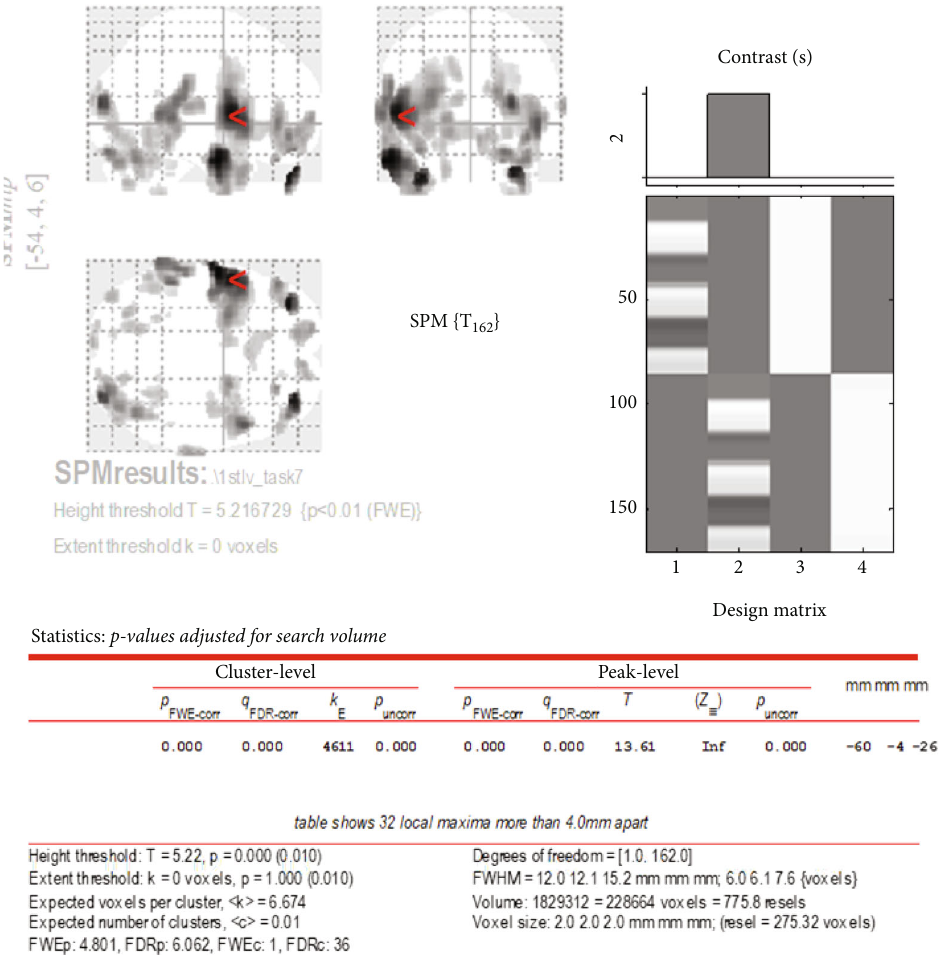
Figure 6: T value of brain activation of clenching task at reevaluation